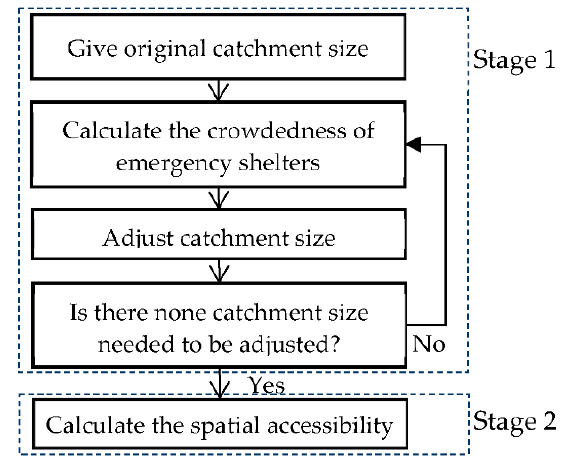
Figure 2. Flowchart of the proposed variable catchment size 2SFCA (A-2SFCA) method.